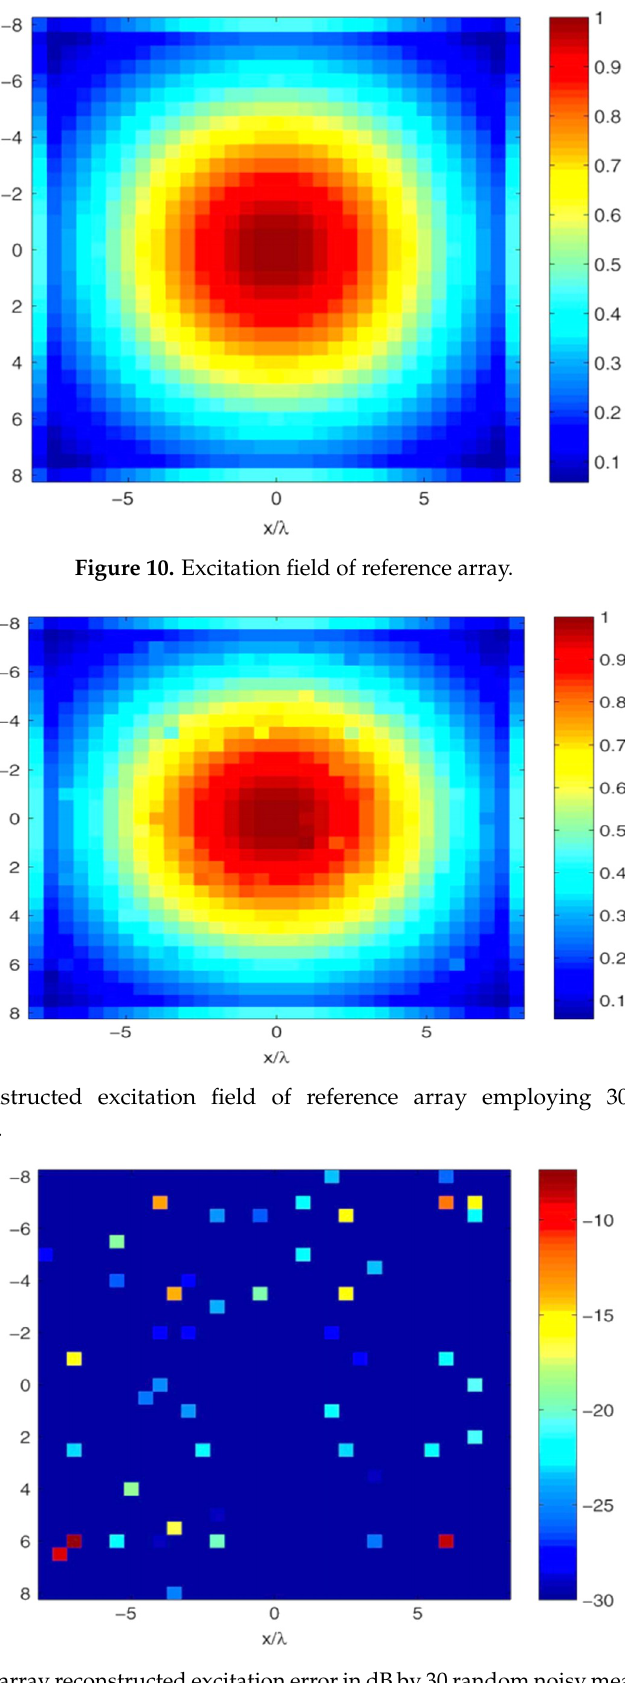
Figure 12. Reference array reconstructed excitation error in dB by 30 random noisy measurement points.